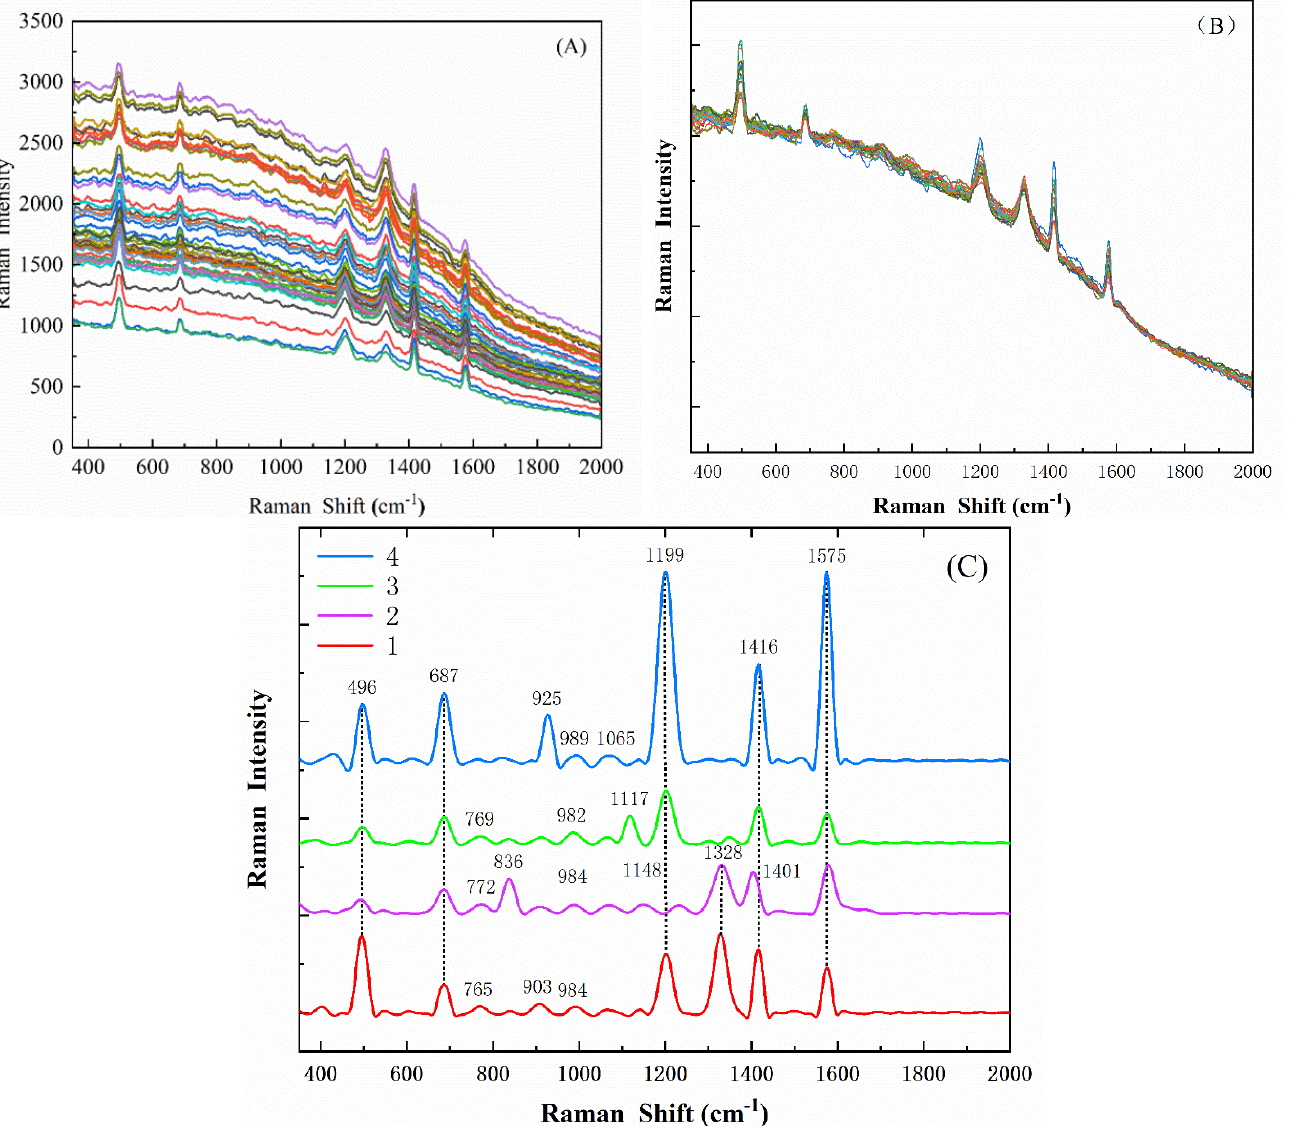
Figure 7. Raman analysis: ( A ) SG-smoothed spectrum after removing cosmic spikes; ( B ) spectra processed by SNV; ( C ) average Raman spectra of four diseased spores.